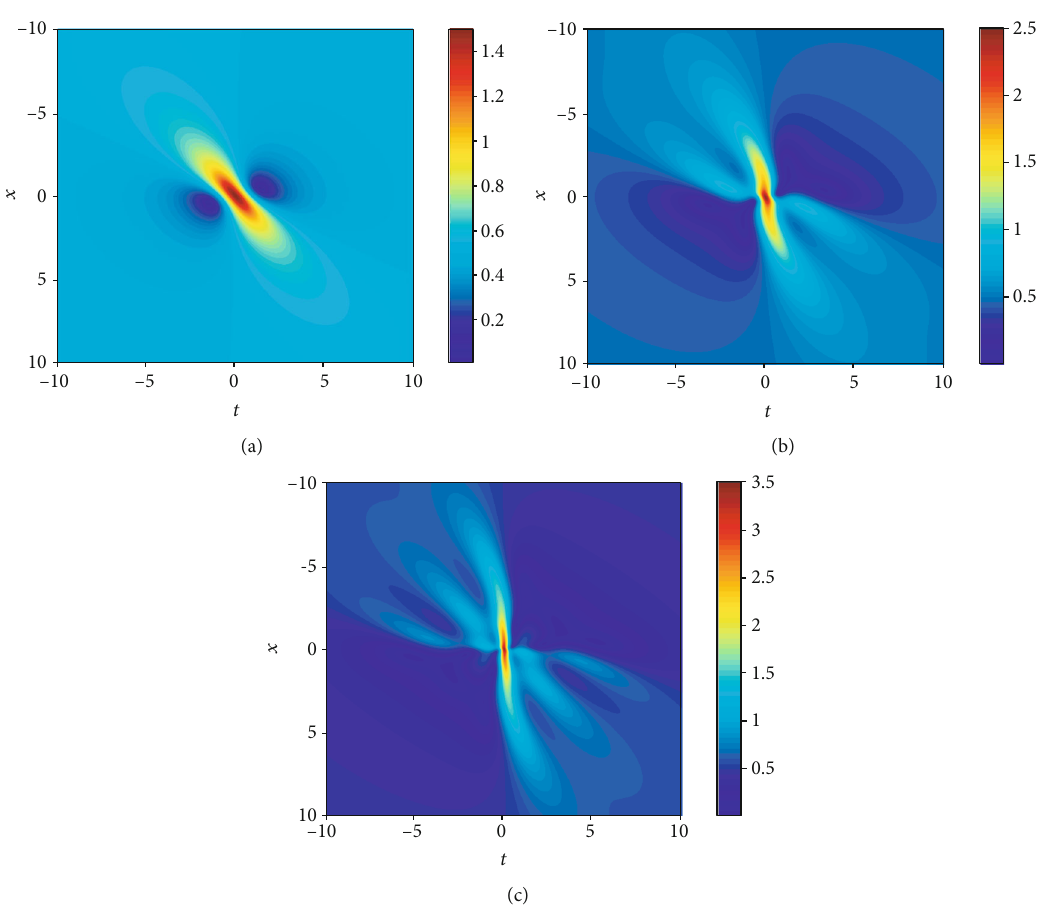
ffiffiffi p = ð i /2 Þ + ð 3 /2 Þ , a = i /2 , and b = 1 (color online). (a) First-order rogue 1